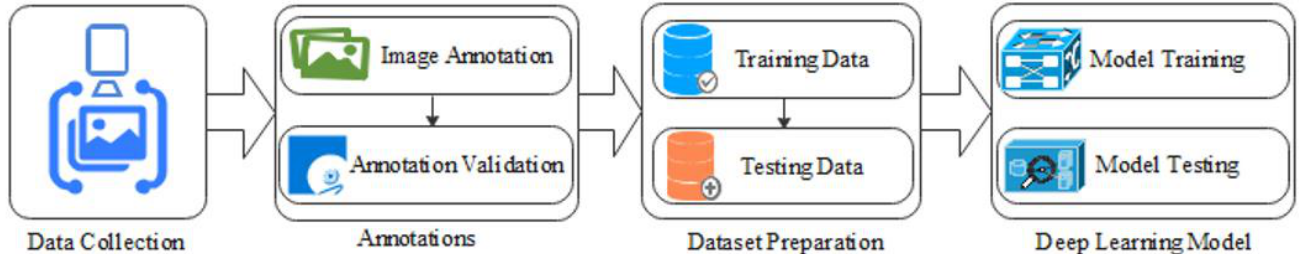
Figure 5. Nephrops burrows detection framework.